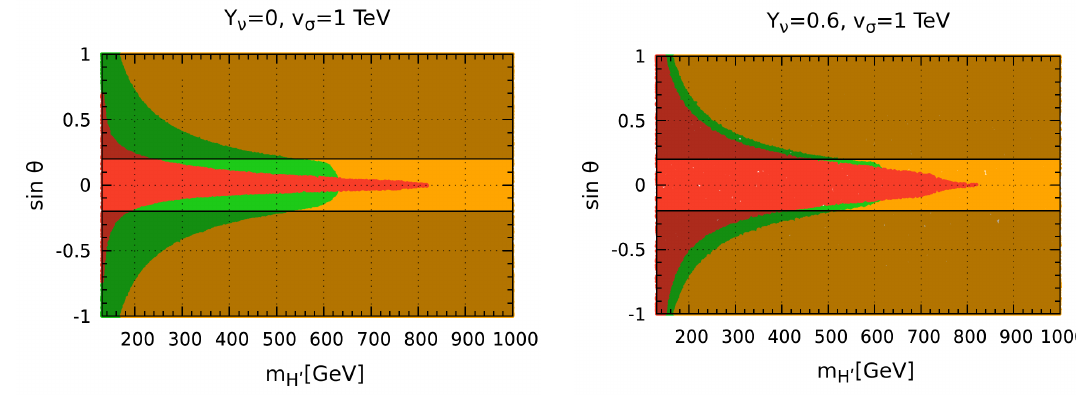
Figure 16 . Values of m H 0 and mixing angle θ leading to a bounded-from-below and perturbative vacuum (green), non-perturbative couplings at some energy scale (brown), or unstable vacuum (red). We have fixed the neutrino scale Λ = 10 TeV and v = 1 TeV, taking Y = 0 and 0.6 for the left and σ ν right panels, respectively. Stability-perturbativity constraints are imposed up to the Planck scale. The region between the black lines is allowed by LEP-LHC constraints.